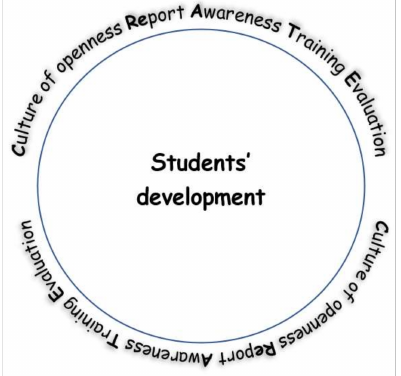
Figure 2. The CReATE circle for recognising students’ psychological symptoms, provide support and help students